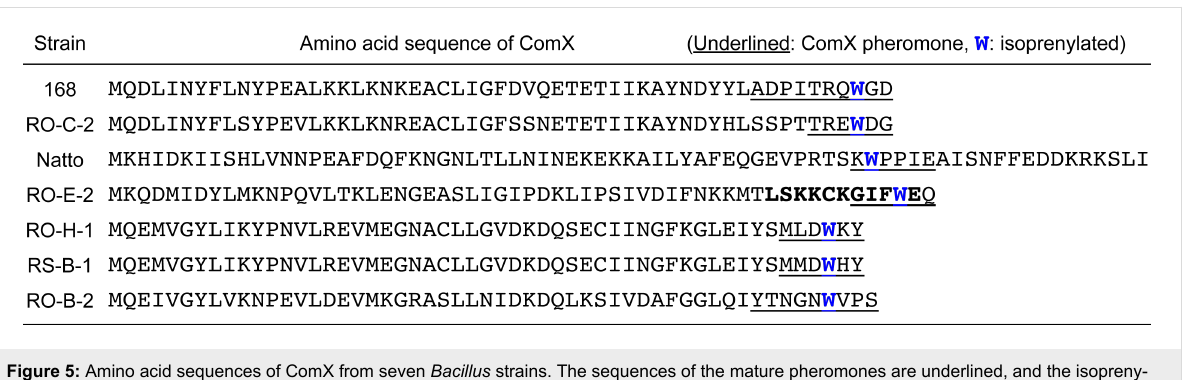
and GGPP synthases possess the DDxx(D) amino acid se- quence in the SARM, the sequence is unsuitable for the isoprenylation of